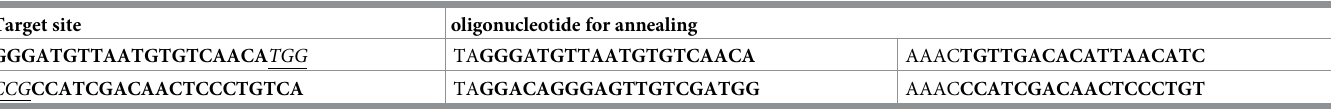
Table 3. gRNA target sites for lrrk2 locus deletion. Target